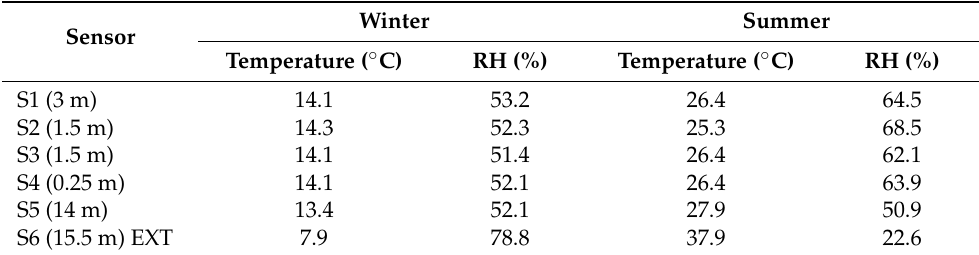
Table 3. Real data from the sensors used for the simulations.